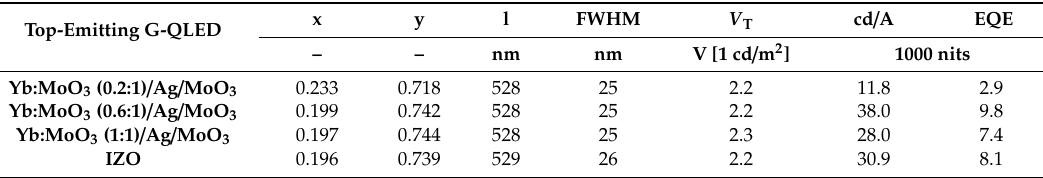
Table 2. Summaries of 1931 CIE (x, y) chromaticity co-ordinates, electroluminescence emission peak e ffi ciency ( η EQE ) of the green top-emission QLEDs with di ff erent top transparent cathodes. Turn-on voltage is measured at 1 cd / m 2